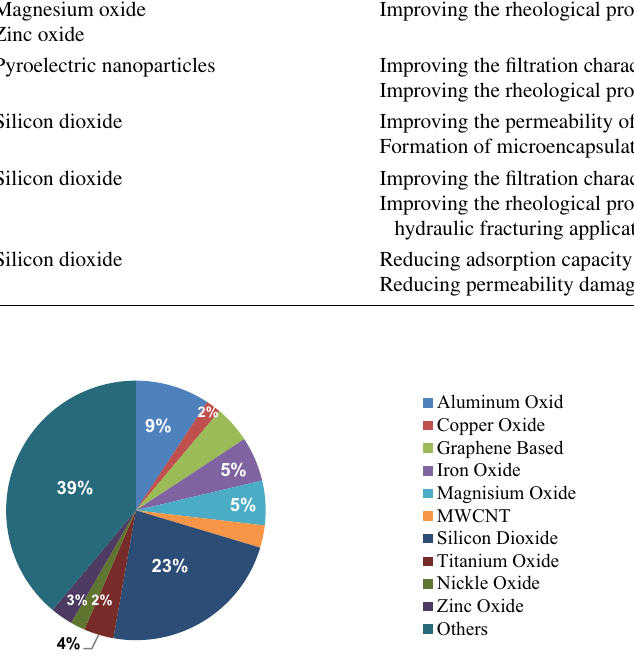
Table 4 Application of nanoparticles for well stimulation Investigated NP